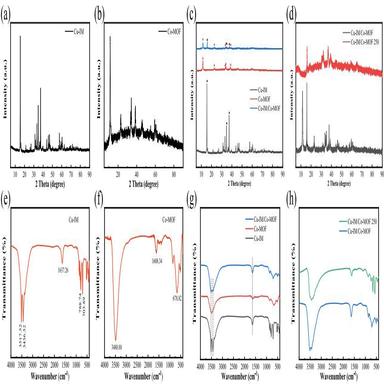
(a-d) XRD patterns of the as-synthesized samples, (e-h) FTIR spectra of the as-synthesized samples.